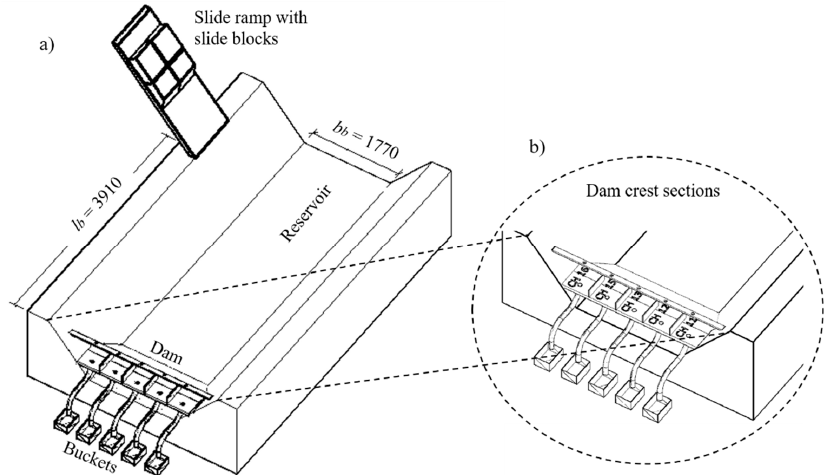
Figure 4. ( a ) Experimental set-up with the main components; slide, reservoir, dam and ( b ) ultrasonic sensors used for measuring the run-up height and buckets for collecting the overtopping water. The